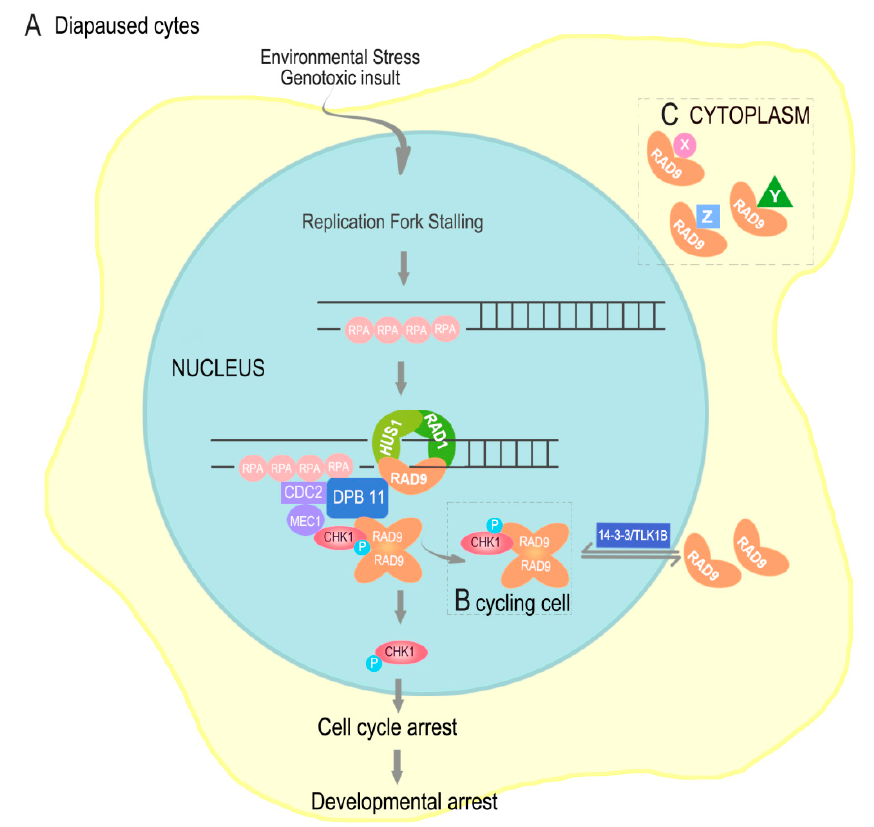
Figure 10. The different functions that As– RAD9 may be involved in. ( A ) The checkpoint signaling Figure 10. The di ff erent functions that As –RAD9 may be involved in. ( A ) The checkpoint signaling pathway that may lead to cell and organic developmental arrest; ( B ) The CHK1/RAD9 complex in pathway that may lead to cell and organic developmental arrest; ( B ) The CHK1 / RAD9 complex in cycling cells; ( C ) Monomer As– RAD9 may interact with different proteins and be involved in various cycling cells; ( C ) Monomer As –RAD9 may interact with di ff erent proteins and be involved in various signaling pathways. signaling